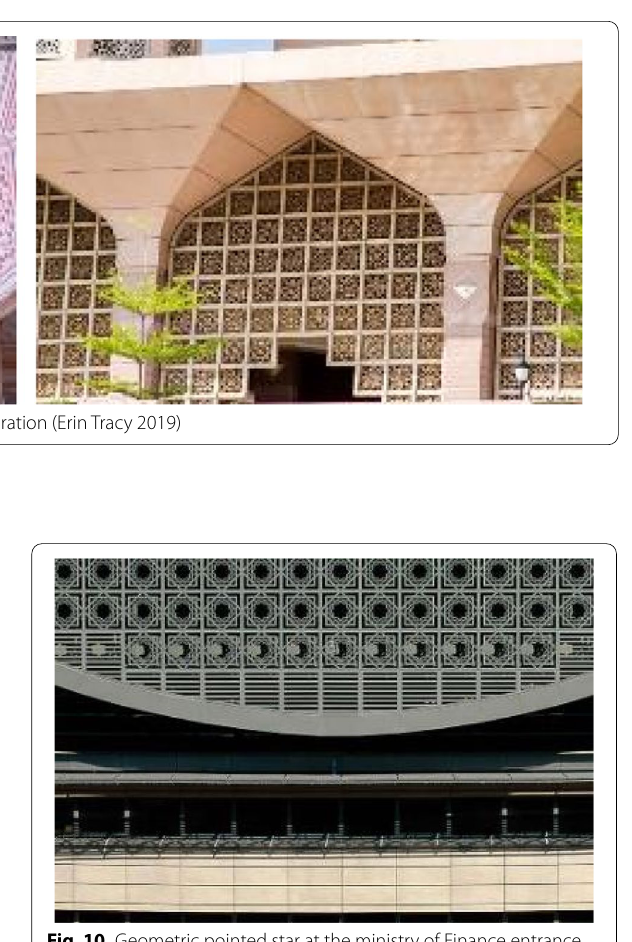
Fig. 10 Geometric pointed star at the ministry of Finance entrance (GDP web, 2020)